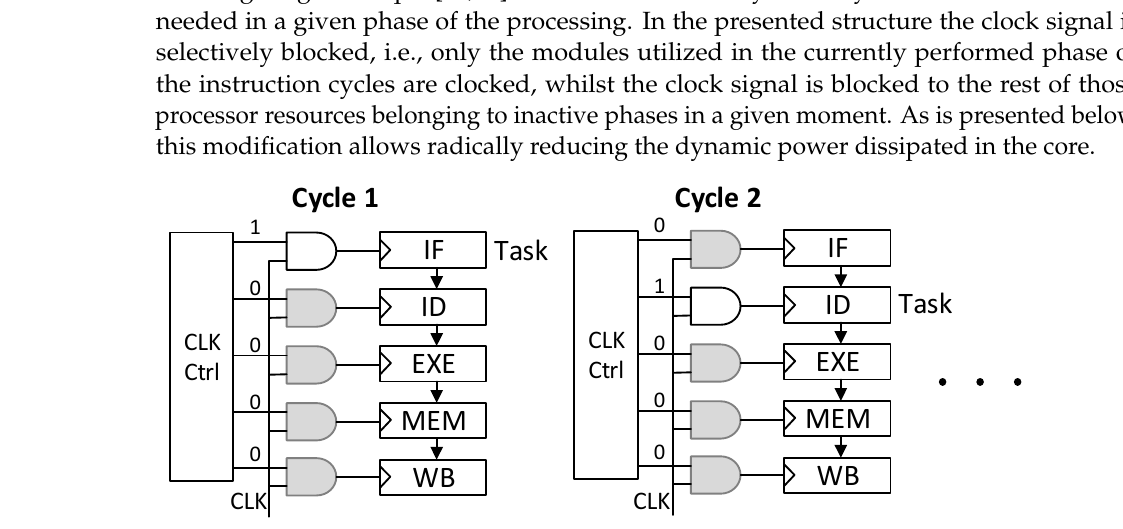
Figure 4. Structure of a classical simple processor with the clock gating of unused phases.